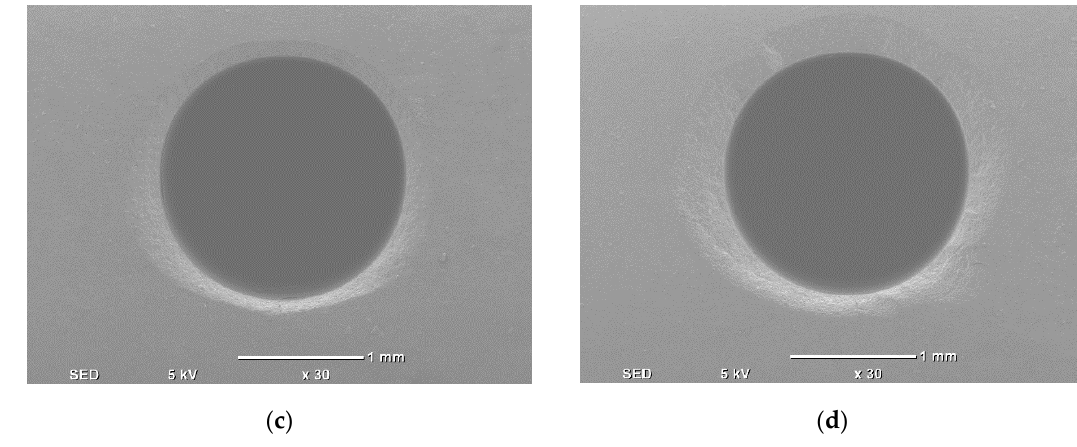
Figure 17. SEM image. ( a ) Top side of the hole (experiment #19). ( b ) Top side of the hole (experiment #21). ( c ) Bottom side of the hole (experiment #19). ( d ) Bottom side of the hole (experiment #21). Holes #19 and #21 were selected since they were the results of the optimal parameters setting.